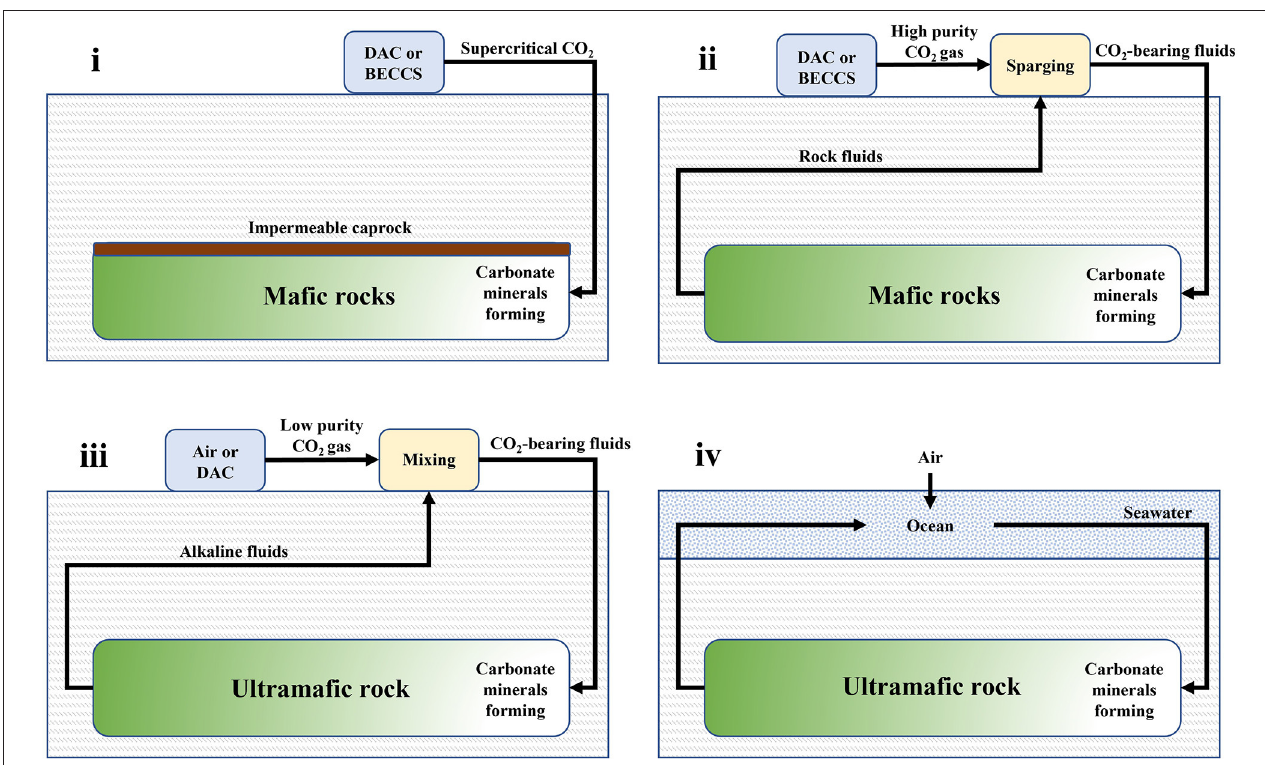
FIGURE 3 | Schematics of four negative emissions approaches for in situ mineralization, i.e., (i) water-charged supercritical CO 2 injection into mafic rock; (ii) CO 2 -bearing fluids circulated through mafic rock; (iii) CO 2 -bearing fluids circulated through ultramafic rock; and (iv) seawater circulation through ultramafic